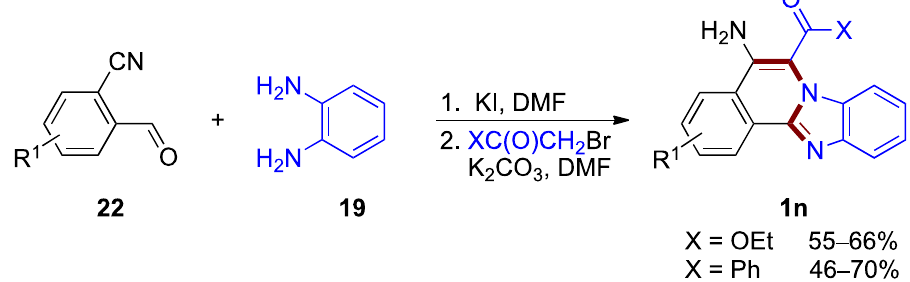
Figure 17. One-pot tandem cyclization leading to 5-amino- and 6-carbonyl functionalized benzimi- dazo[2,1- a ]isoquinolines 1n .